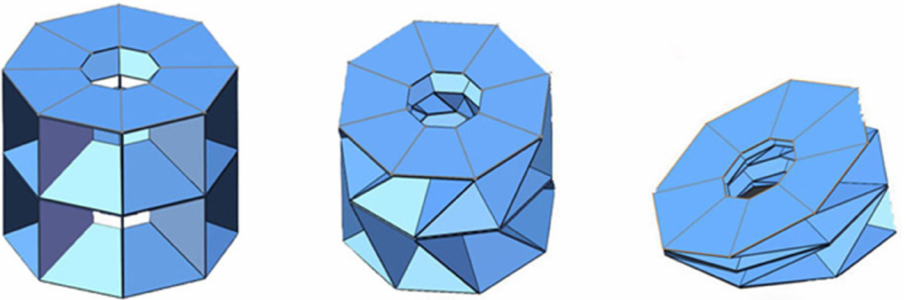
Figure 1. Extension, contraction, and bending motions of a twisted tower. The one-layer twisted tower can be assembled from 16 basic segments, as shown in Figure 2. The paper used for forming the basic segments has a size of 6 cm × 3 cm and a thickness of 0.2 mm. The basic segment determines the length of the link plate and the initial height of the one-layer tower. Several types of paper with different thickness, from 0.08 mm to 1.0 mm, are tested and compared during the assembly process. Thick paper is not suitable for folding, while thin paper is easy to break; the 0.2 mm thickness paper can provide both good foldability and sufficient stiffness.